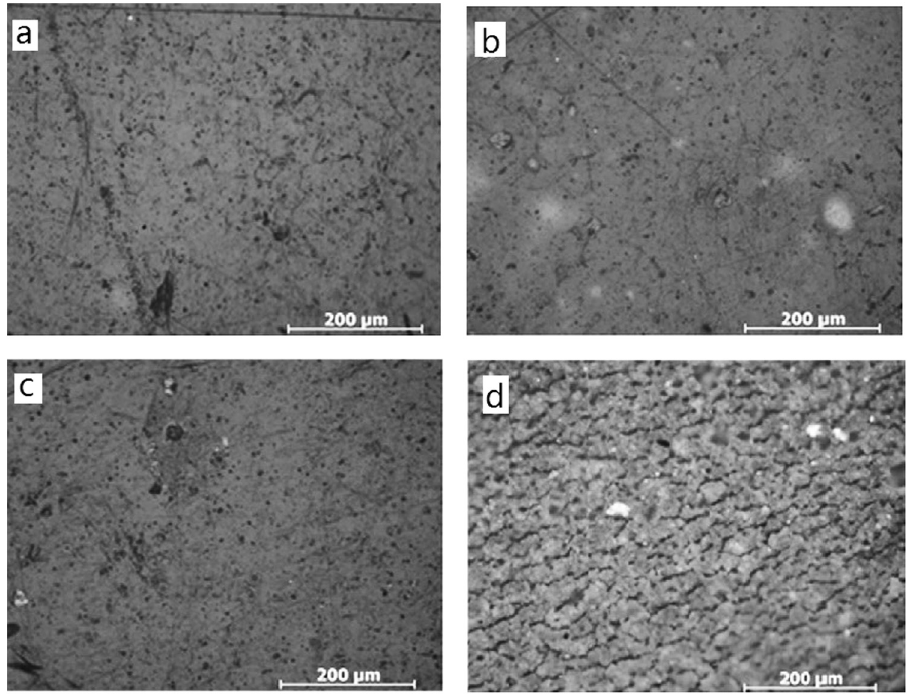
Figure 1: Micromorphology of samples exposed to test solutions: ( a ) unexposed, ( b ) for 33 days - RS, ( c ) unexposed, and ( d ) for 33 days – ADT.